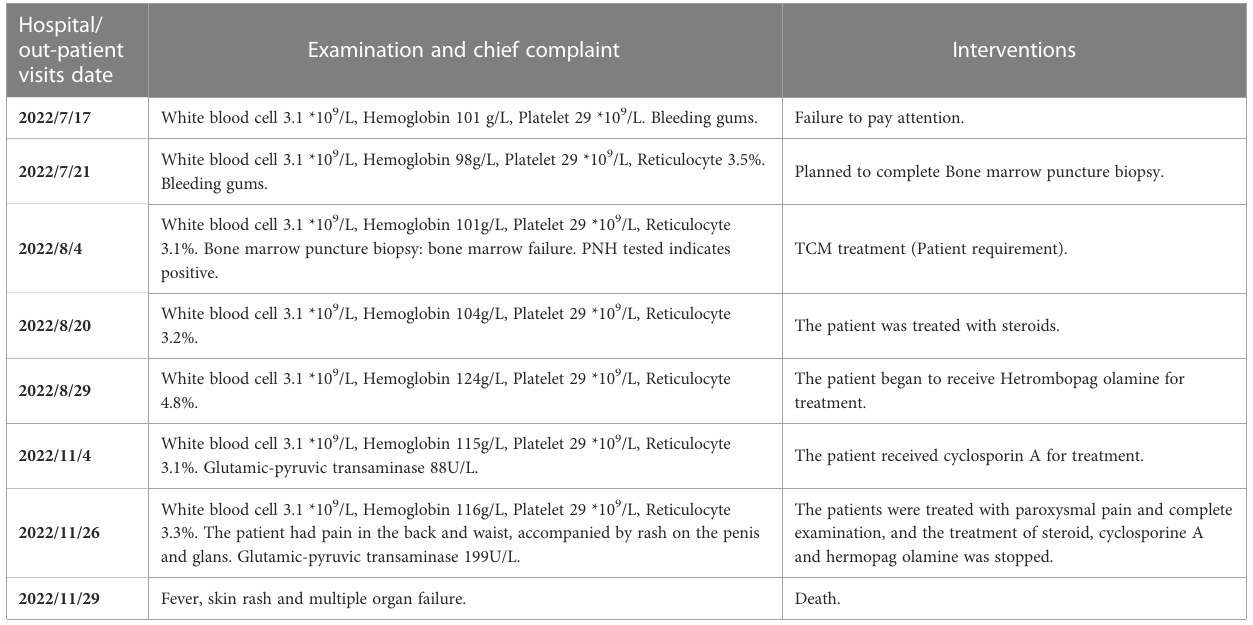
TABLE 1 Timeline of patient ’ s medical